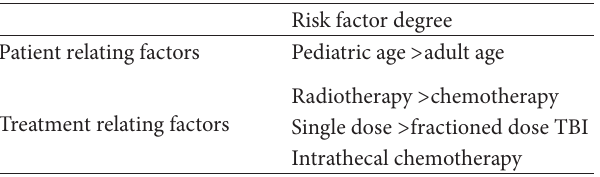
Table 2: Risk factors for GH